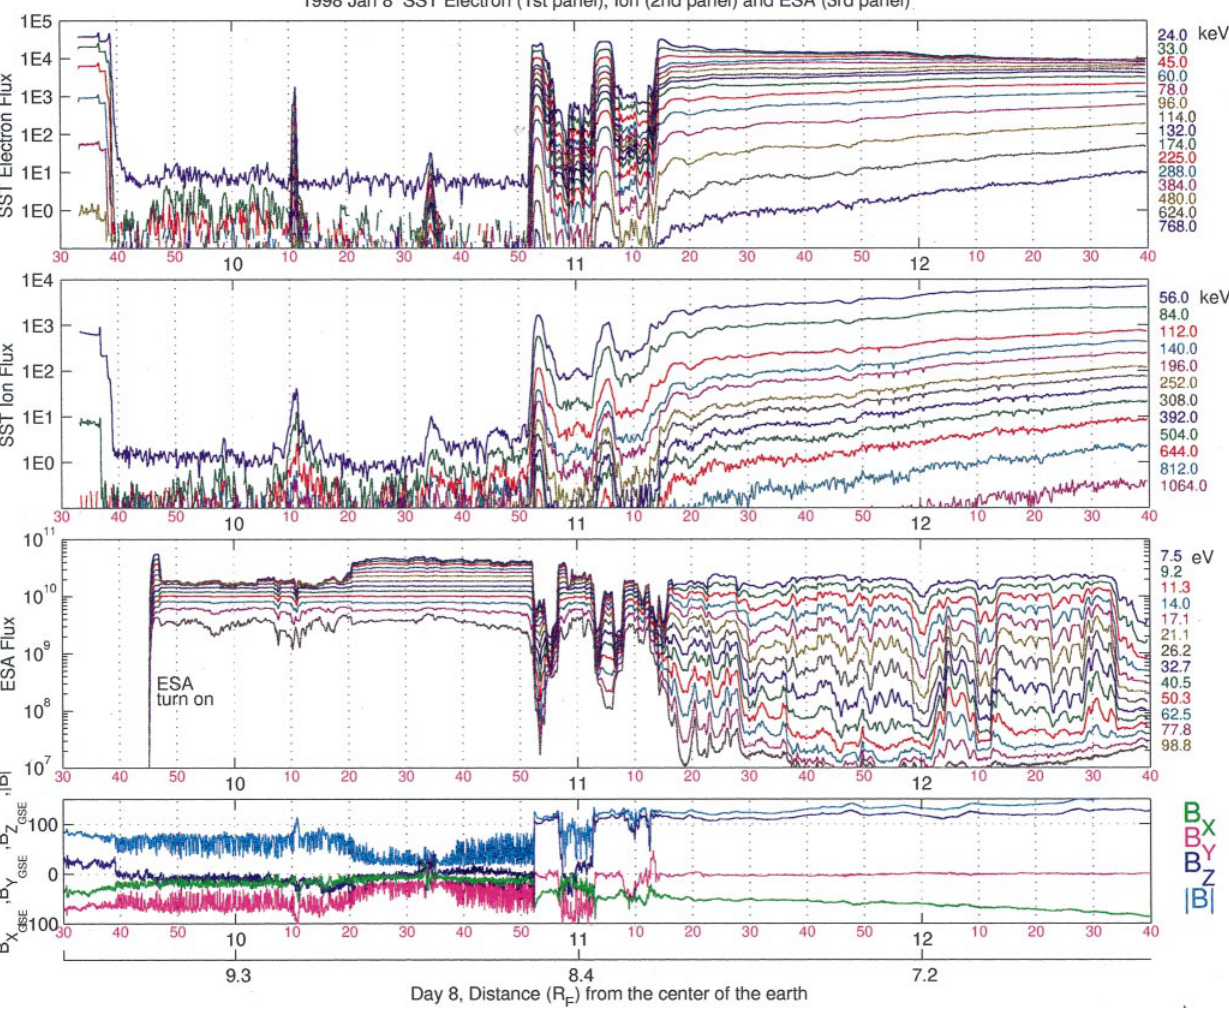
magnetic field and its components ( fourth panel ). Key features to note are multiple boundary crossings